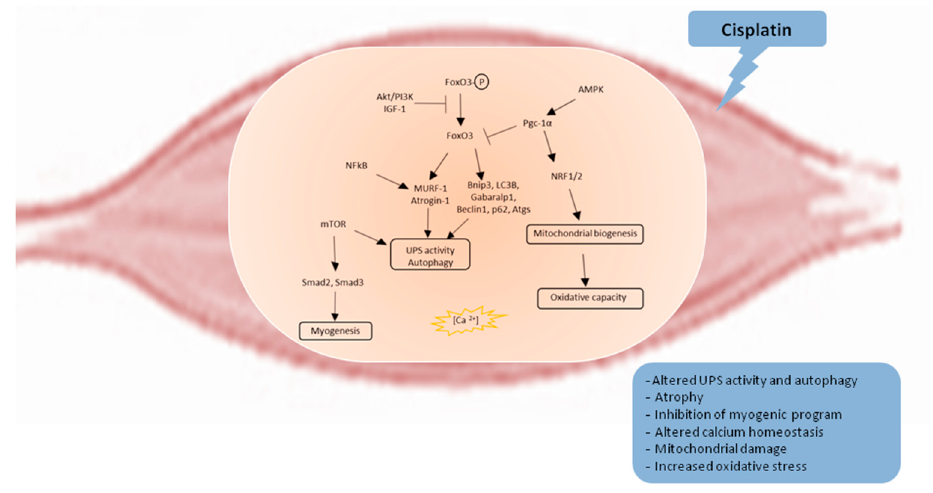
Figure 1. Molecular mechanism underlying cisplatin-induced muscle wasting. AMPK: 5’-adenosine monophosphate-activated protein kinase; Akt: Protein kinase B; Atgs: Autophagy-specific genes; Bnip3: BCL2 interacting protein 3; FoxO3: Forkhead boxO, Gabaralp1: GABA type A receptor-associated protein-like 1; IGF-1: Insulin-like growth factor-1; IL-1: Interleukin-1; IL-6: Interleukin-6; LC3B: Lipidated microtubule-associated protein 1 light chain 3 alpha; mTOR: Mammalian target of rapamycin; MuRF-1: Muscle ring-finger-1; NF κ B: Prototypical nuclear factor kappa light-chain-enhancer of activated B cells; NRF1/2: Nuclear respiratory factor 1/2; p62: Sequestosome-1; PGC-1 α : Peroxisome proliferator-activated receptor γ coactivator-1 α ; PI3K: Phosphoinositide 3-kinases; Smad2/3: Small mother against decapentaplegic.